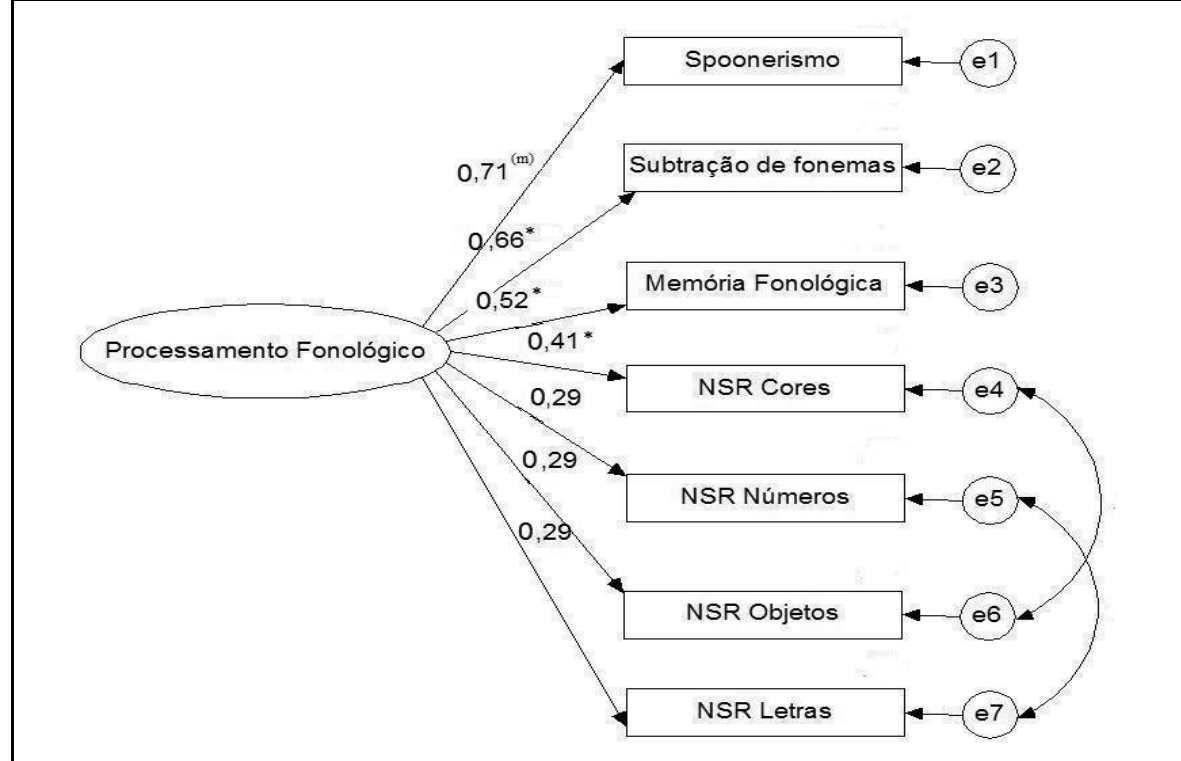
Figura 1. Diagrama do modelo com um único fator (representação da proposta de Wagner & Torgesen, 1987).